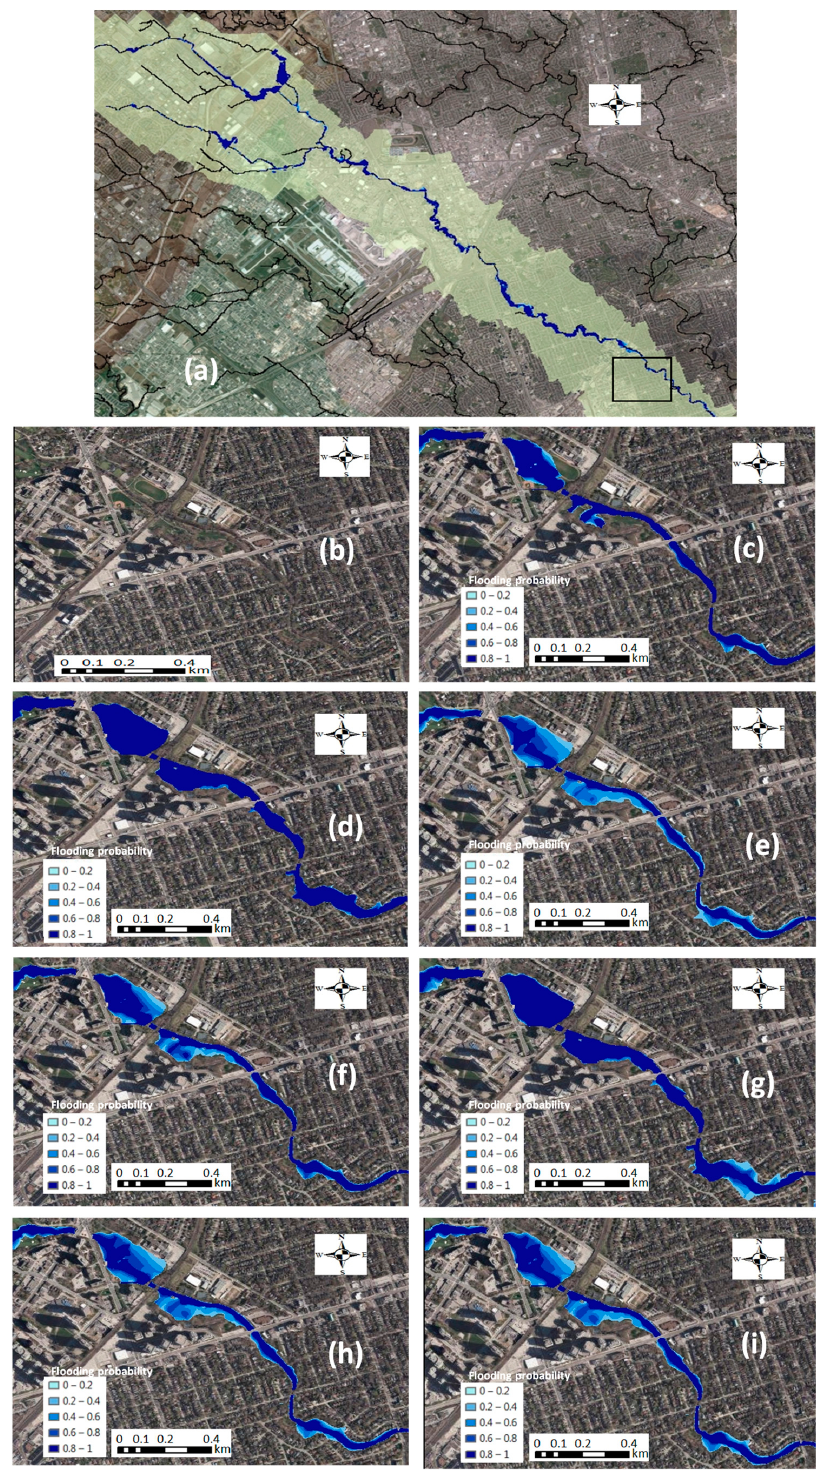
Figure 6. Probabilistic floodplain maps for ( a ) a selected part of the watershed (area designated with the square) corre-spond to different scenarios ( b ) no flooding; ( c ) scenario 1; ( d ) scenario 2; ( e ) scenario 3; ( f ) scenario 4; ( g ) scenario 5; ( h ) scenario 6; ( i ) scenario 7.